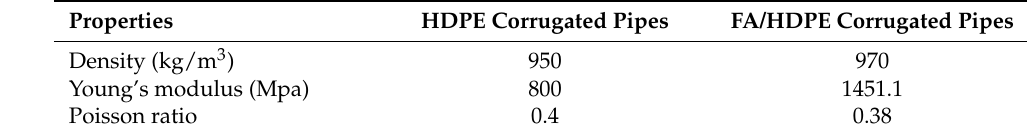
Table 4. Material parameter of pipes.